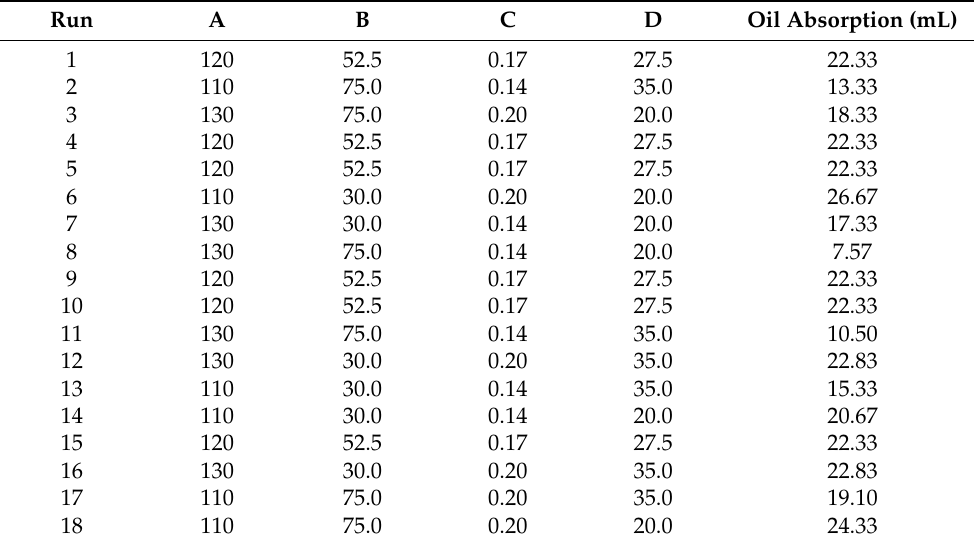
Table 3. Secondary screening of significant parameters affecting diesel sorption using Plackett Burman design for cogon grass (SD, n = 3).